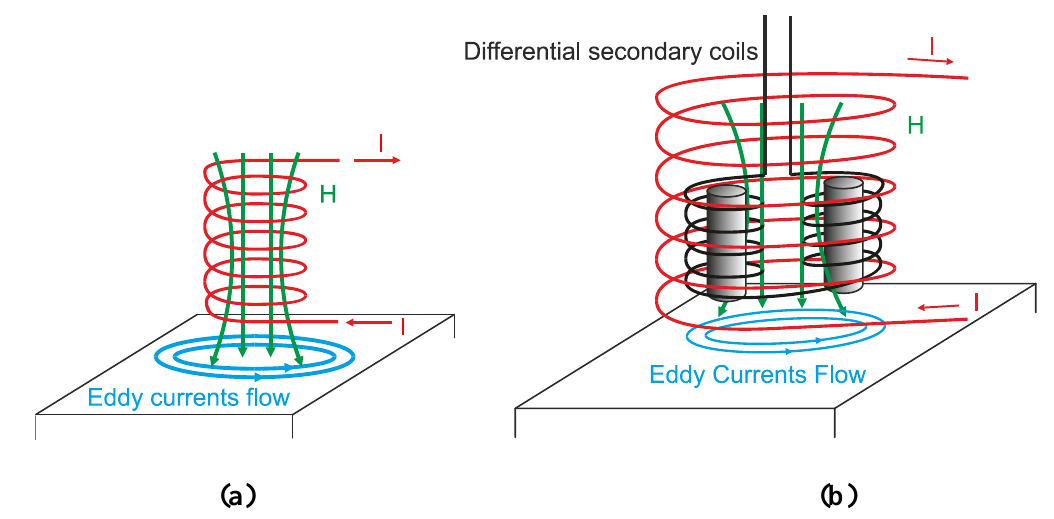
Figure 20. (a) Double-function single coil probe. (b) Differential separated function